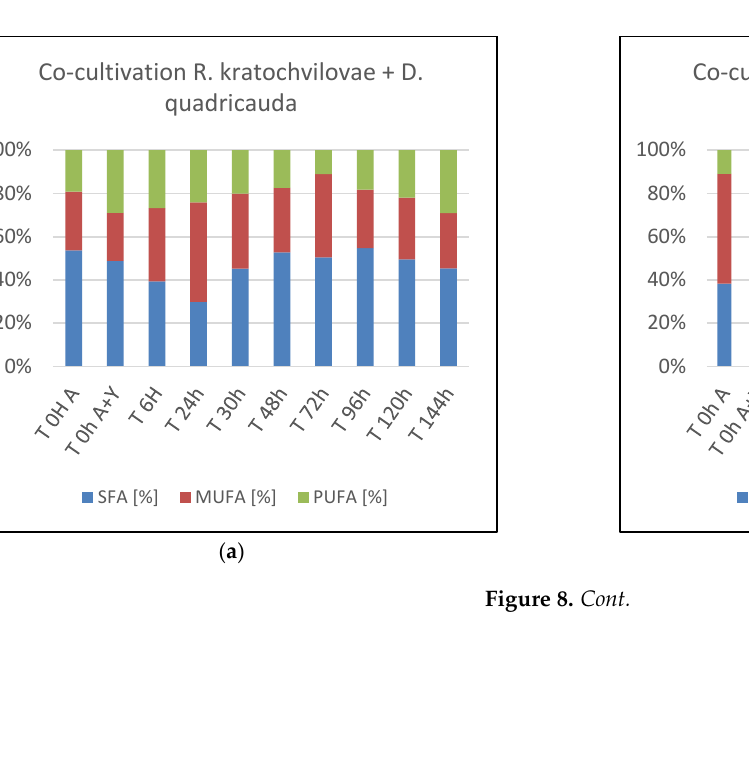
Figure 7. Time course of total lipid production in co-cultures of Rhodotorula kratochvilovae and Desmodesmus sp.